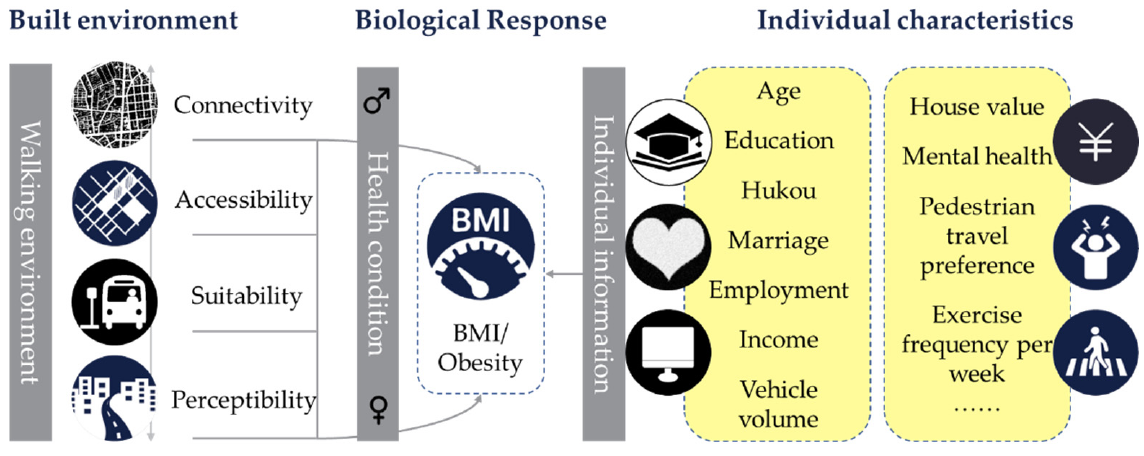
Figure 1. Research framework.